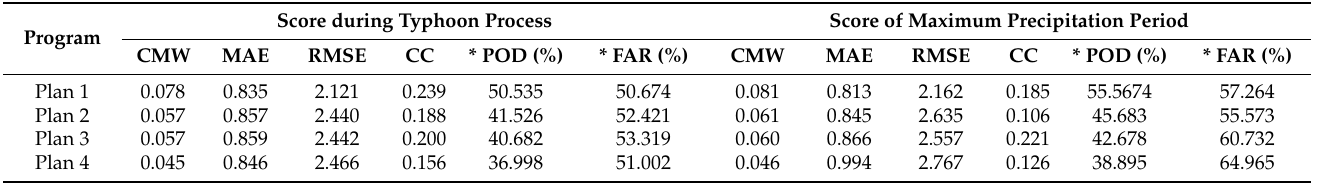
Table 5. The different verification scores of hourly precipitation forecast in the next six hours from 20:00 on 25 August to 02:00 on 26 August 2019.